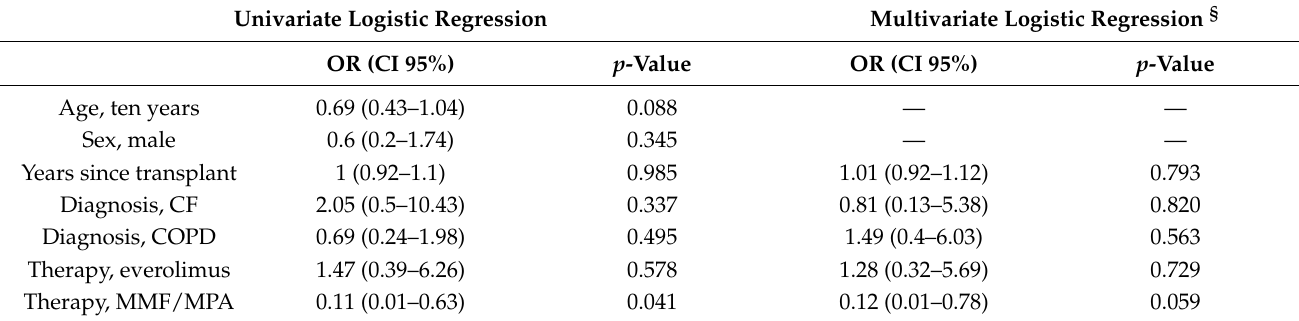
§ Logistic regression models for diagnosis of CF (cystic fibrosis), diagnosis of COPD (chronic obstructive pul-